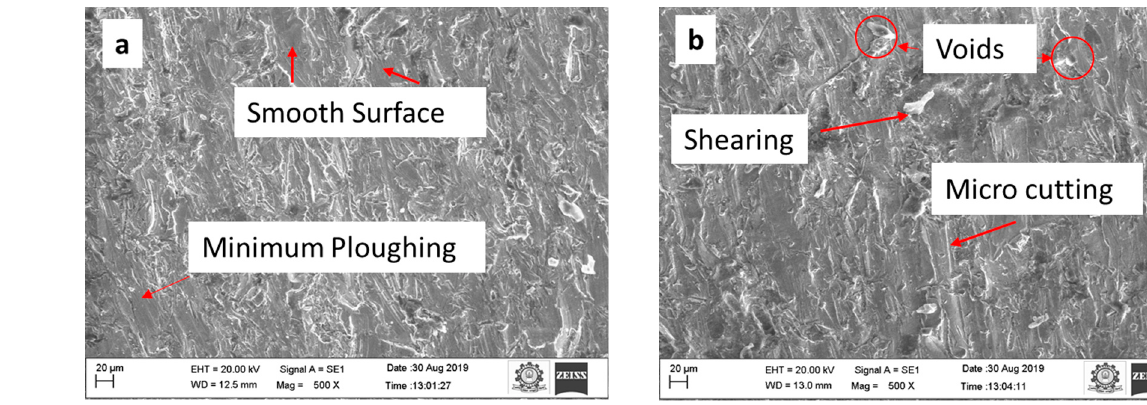
Figure 7. AWJM surface micrograph at SOD = 2 mm, JT = 15 mm/min, and P = 260 MPa ( a ) top, ( b ) middle, and ( c ) bottom region.